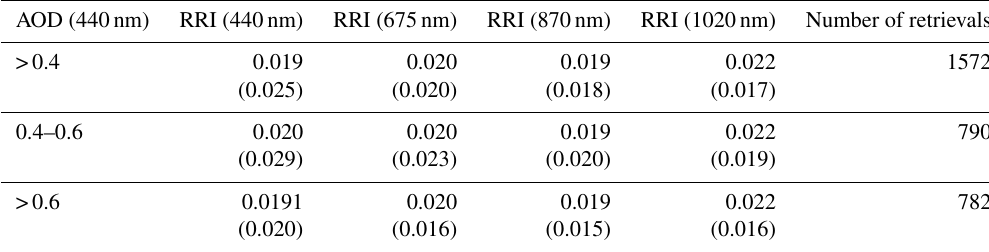
Table 8. Statistics, average values and standard deviations (in parentheses) of the difference in the RRI retrievals of V2 and V3 for the Mongu site. The difference is defined as V3 −